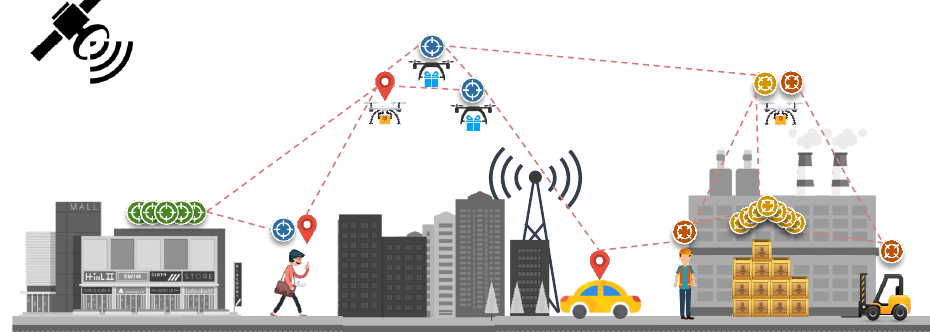
Figure 2. The vision for the integration of the localization and IoT technologies.